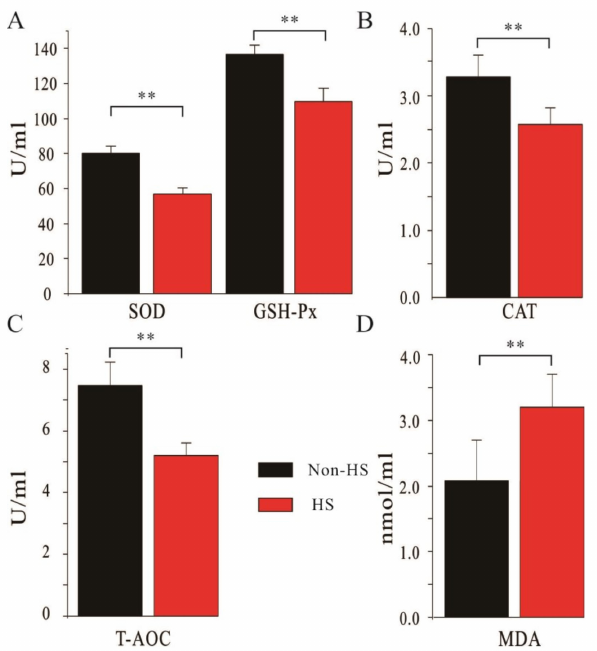
Figure 2. Serum antioxidant capacities of dairy cows in non-HS and HS season. All the 40 dairy cows were fed with standard diet. Blood samples were collected during spring (non-HS season) and summer (HS season), respectively. Superoxide dismutase (SOD) and glutathione peroxidase (GSH-Px) ( A ), catalase (CAT) ( B ), total antioxidation (T-AOC) ( C ), and malondialdehyde (MDA) ( D ) levels in the serum of dairy cows in non-HS and HS seasons. **: p < 0.01